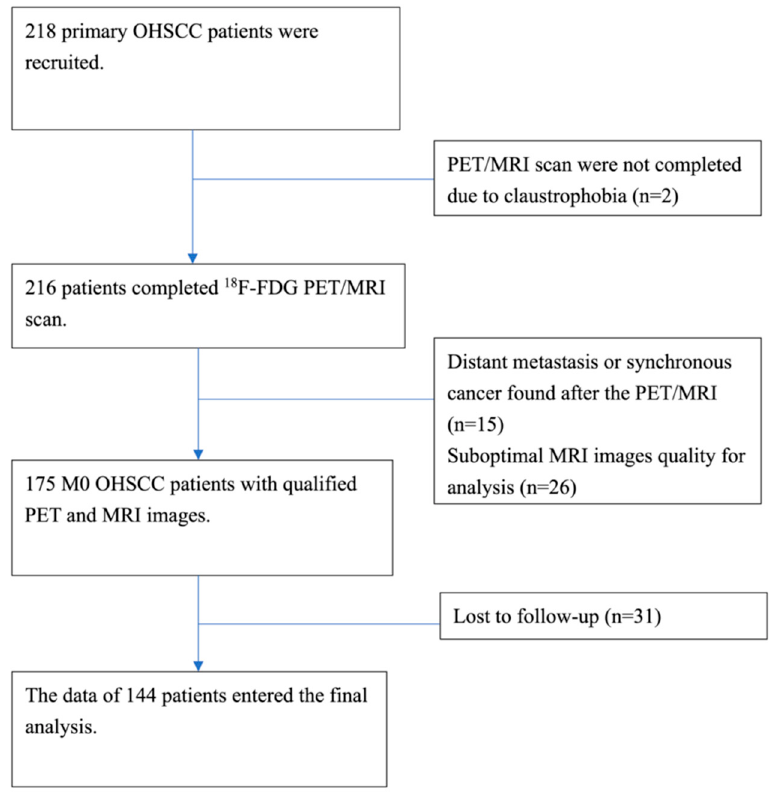
Figure 1. Study flowchart. OHSCC: oropharyngeal and hypopharyngeal squamous cell carcinoma. Table 2. General characteristics of the study participants ( n = 144).